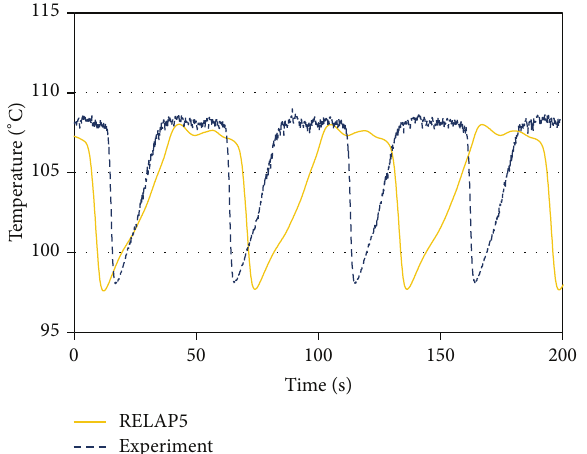
Figure 13: Inlet flow rate, test I-2.